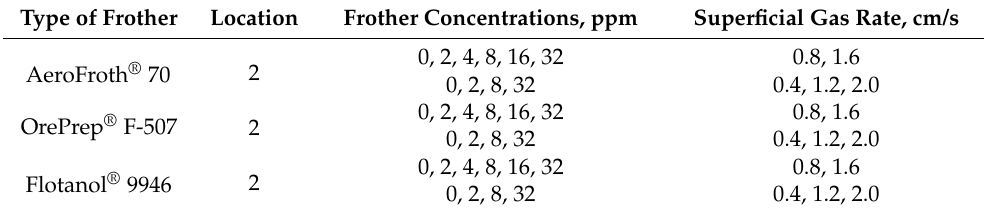
Table 2. Flotation tests for